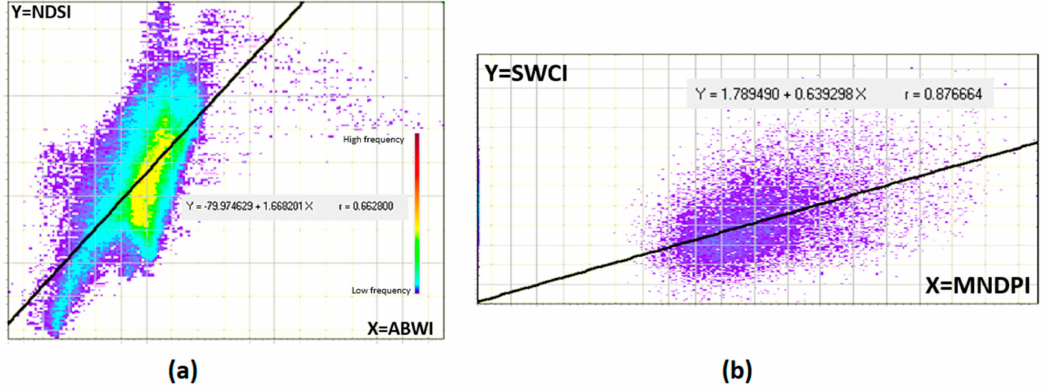
Figure 4. ( a ) the All Band Water Index and the Normalised Di ff erence Salinity Index (ABWI, NDSI) feature space and the regression line, and ( b ) the Microwave-Normalized Di ff erence Polarization Index and Salt Water Cavity Index (MNDPI, SWCI) feature space and the regression